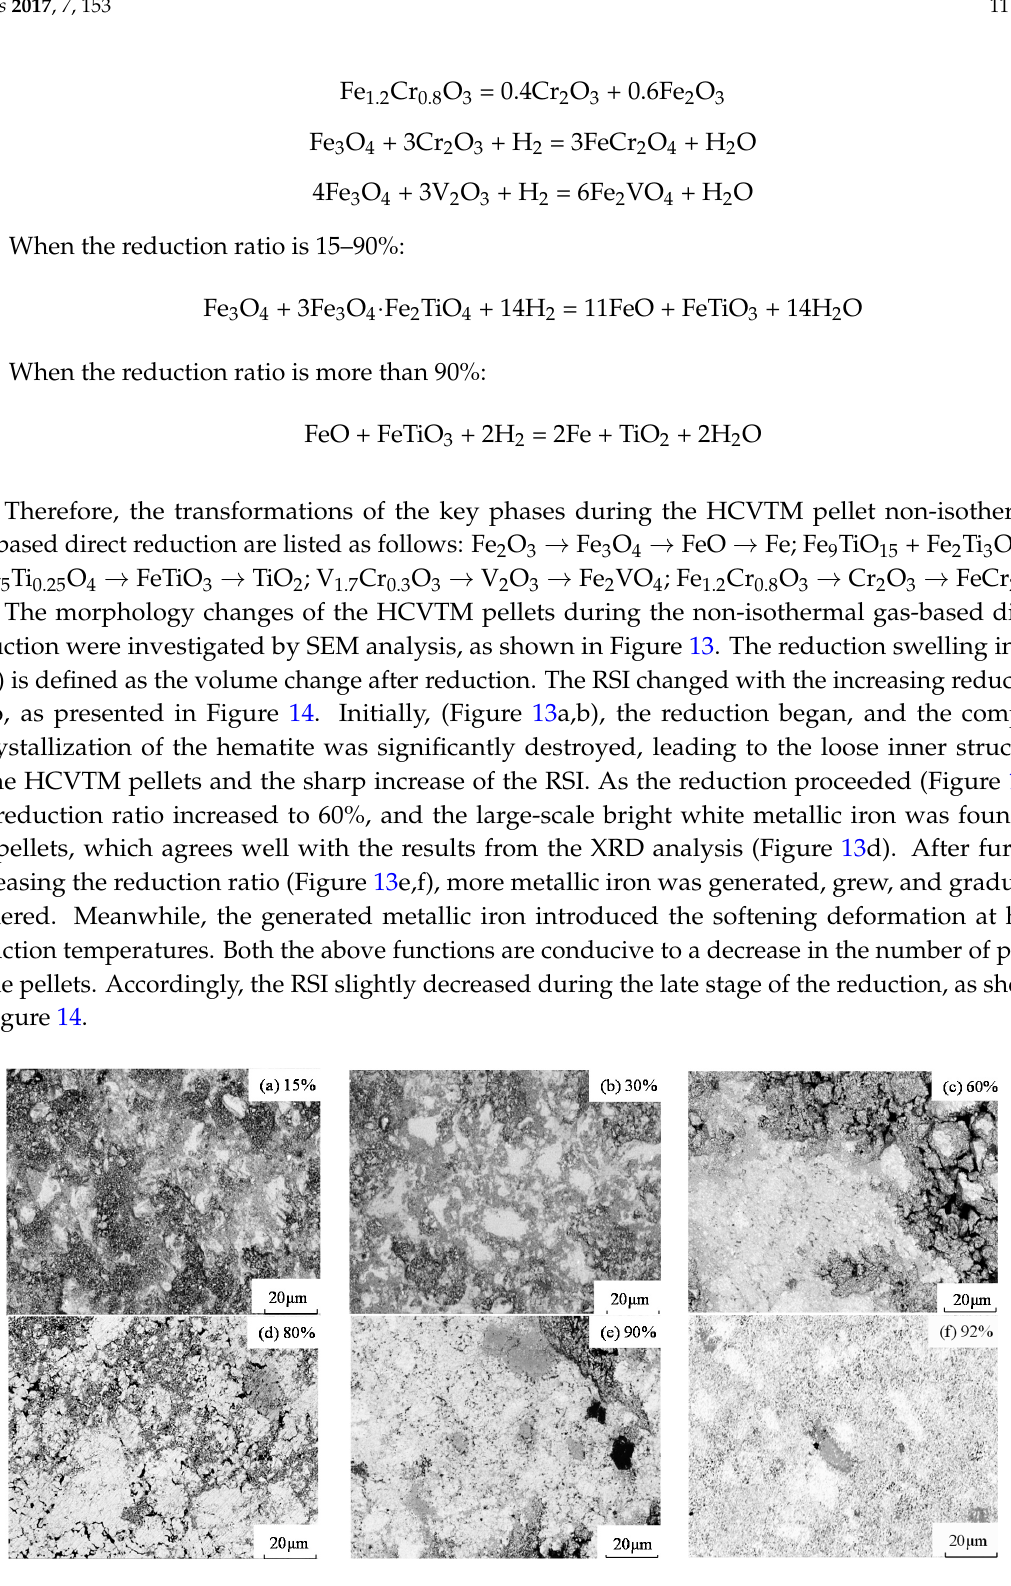
Figure 13. Morphology changes of the HCVTM pellets during the non-isothermal gas-based direct reduction ratios. ( a ) 15%; ( b ) 30%; ( c ) 60%; ( d ) 80%; ( e ) 90%; ( f ) 92%.